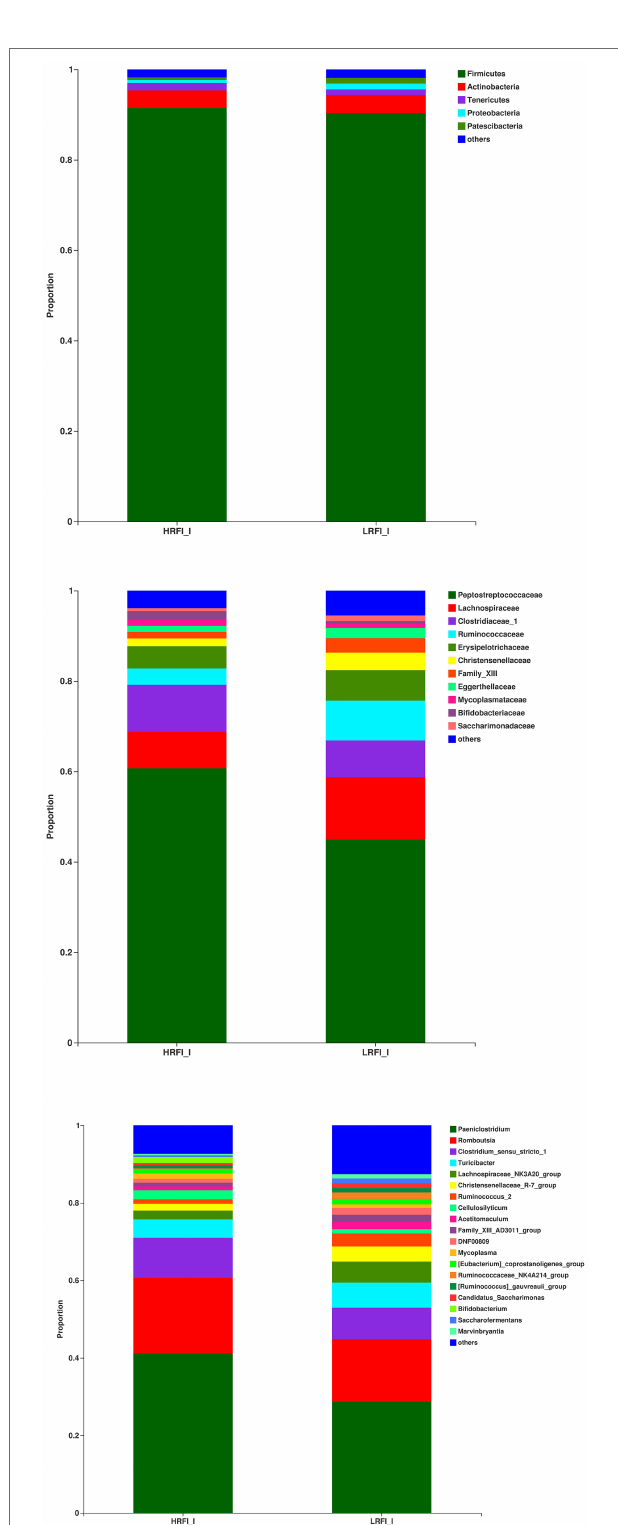
FIGURE 3 | The average proportion of the most dominant jejunum bacteria phyla, families, and genera (relative abundance >1% for all samples).